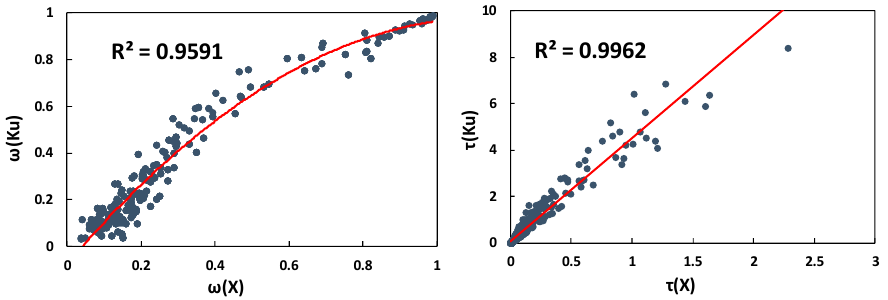
Figure 5. The relationship between single scattering albedo at X band and that at Ku band ( left ) and the relationship between the snow optical thickness at X bands and at Ku band ( right ).